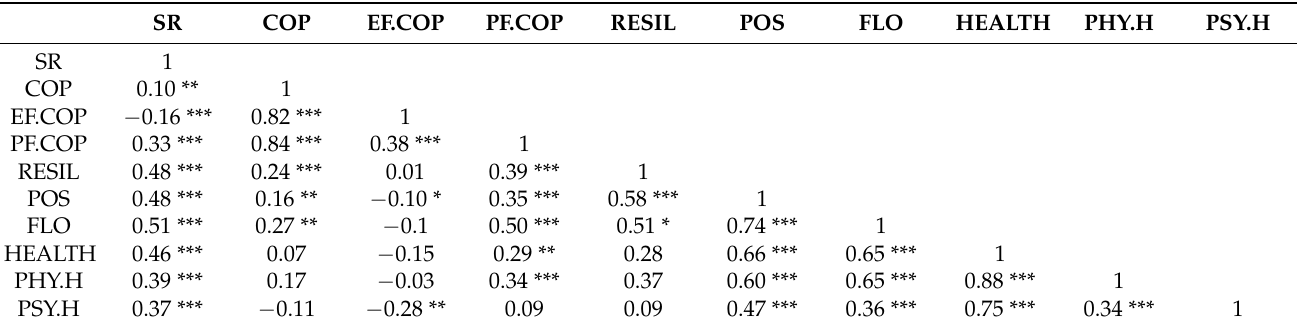
Table 1. Bivariate correlations between presage, process, and product